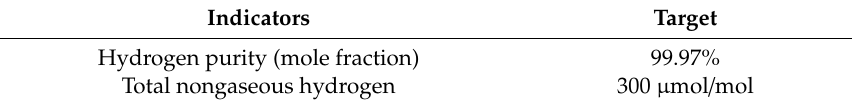
Table 1. Technical indicators of hydrogen fuel for proton exchange membrane (PEM) fuel cell vehicles.